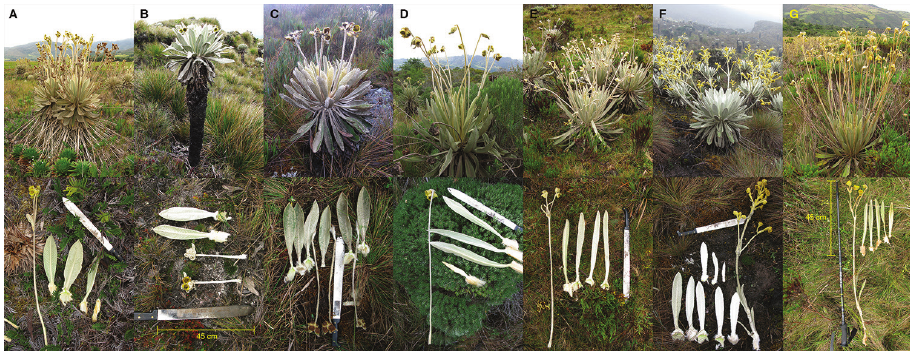
Figure 4. Comparison of similar Espeletia species. A E. brassicoidea B E. canescens C E. conglomerata D E. dugandii E E. praesidentis F E. standleyana G E. steyermarkii . The hygrophilous and always mono- cephalous E. estanislana was not included because of its very distinctive morphology. Above: plant habit; below: adult leaves with sheaths, and complete capitulescences.